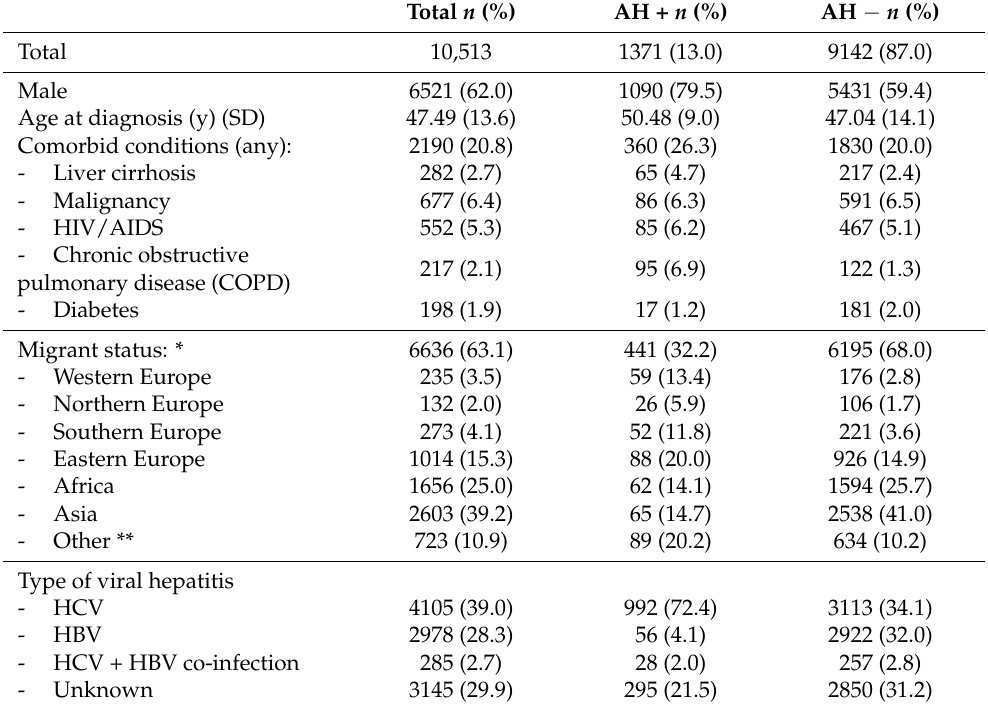
Table 1. Baseline